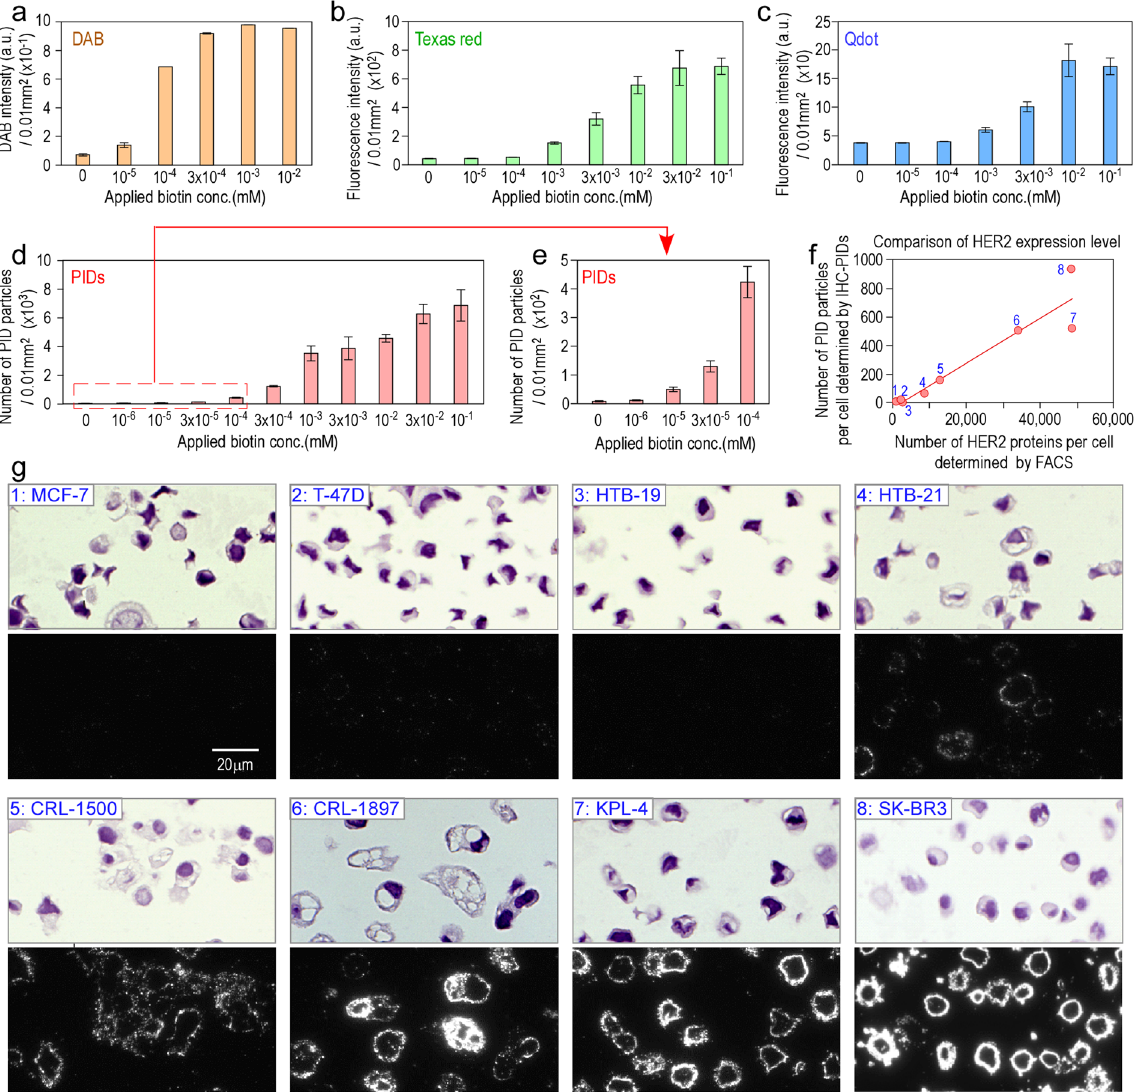
Figure 4. Dynamic range and quantitative sensitivity of IHC-PIDs. The sensitivity of imaging with PIDs ( d , e ) was compared with that with DAB ( a ), Texas Red ( b ), and Qdot 625 ( c ) using deparaffinized paraffin sections of human breast cancer tissues incubated with biotin solutions of varying concentration. The effective dynamic ranges of DAB ( a ), Texas red ( b ), Qdots ( c ), and PIDs ( d , e ) staining were 10 − 5 to 10 − 3 , 10 − 4 to 3 × 10 − 2 , 10 − 4 to 10 − 2 , and 10 − 6 to 10 − 1 mM, respectively. Error bars indicate s.e.m ( a – e ). Next, cultured cells of eight types of breast cancer that express HER2 at various levels were stained with PIDs ( g ) to investigate whether IHC-PIDs can accurately measure the protein expression level in cultured cancer cells. These cells were immunostained with monoclonal anti-HER2 antibody, biotinylated monoclonal secondary antibody, and PIDs and were observed using a versatile fluorescence microscope. The images of all cells are displayed at the same magnification. Bar, 20 μ m. The obtained fluorescence data were analyzed by image-processing method, shown in Figs 2 and 3, to determine the number of PID particles per cell ( f , y -axis). Typical imaging data of these cells with PIDs are shown in ( g ). The HER2 expression levels of these cells were examined using FACS. We determined the mean number of HER2 proteins per cell using a standard curve and a kit for FACS ( f , x -axis). The mean value of the PID particle number per cell ( f , y -axis) was compared with the mean value of HER2 proteins per cell ( f , x -axis), as determined by FACS. The two values were strongly correlated (R = 0.94) ( f ). The sample number in the graph ( f ) corresponds to the cancer cell image in ( g